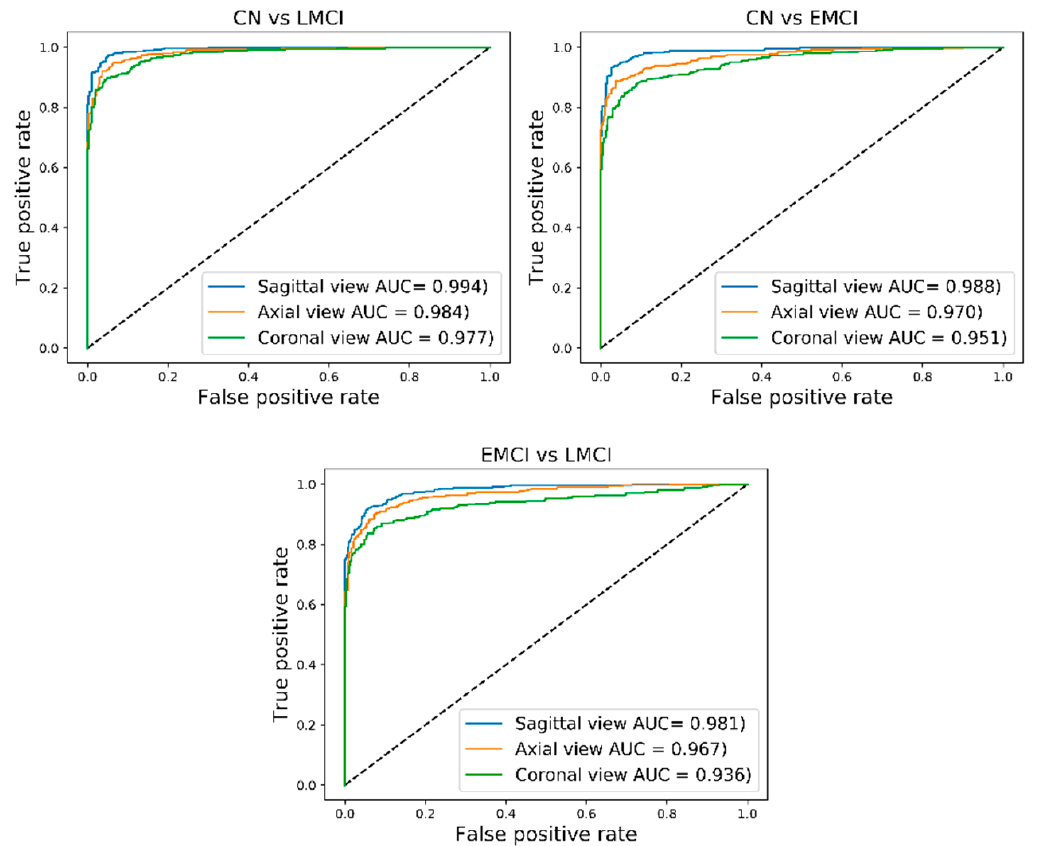
Figure 4. Receiver operating characteristic-area under the curve (ROC-AUC) results of the sagittal, coronal, and axial views.